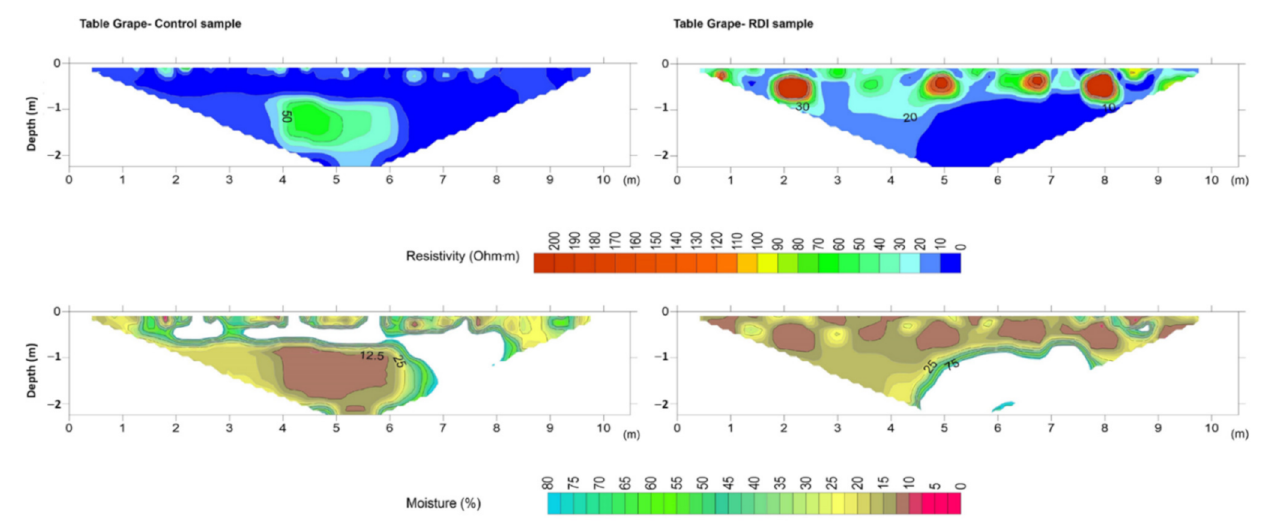
Figure 9. Resistivity model ( top ) and predicted soil moisture ( bottom ) for control ( left ) and deficit irrigation ( right ) in the table grape